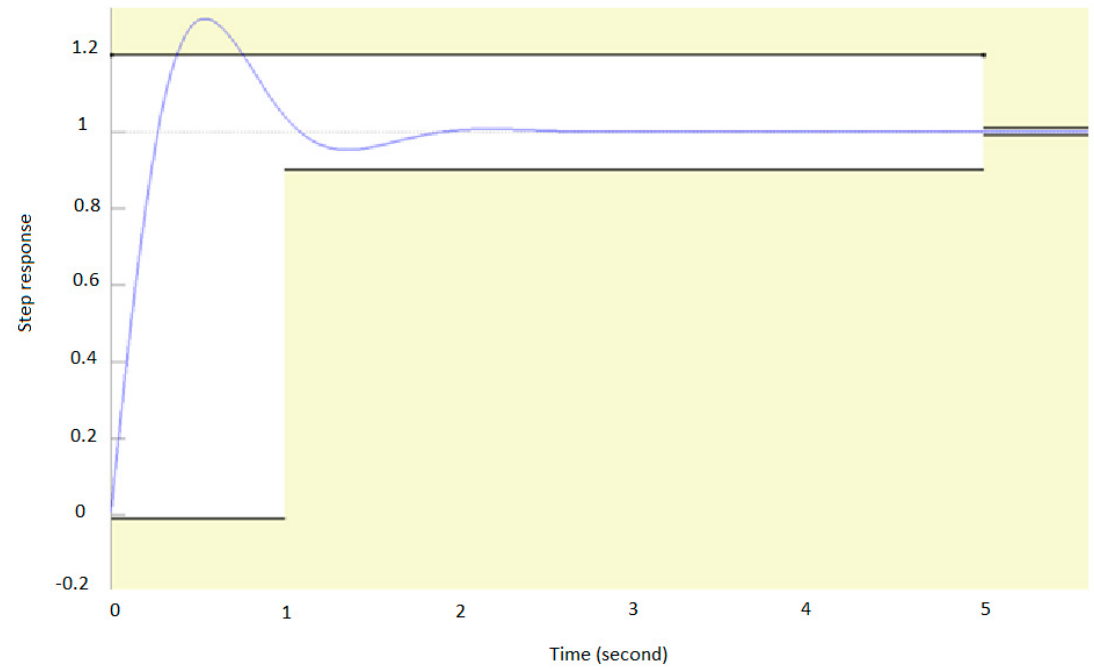
Energies 2021 , 14 , x FOR PEER REVIEW Figure 16. The step response of the control system. Figure 16. The step response of the control system.